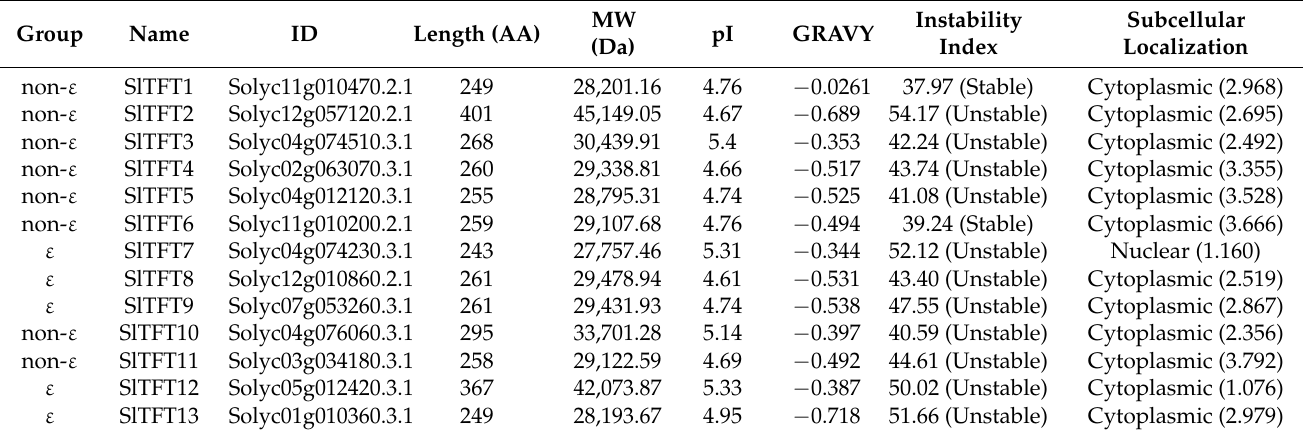
Table 1. Identification and characterization of